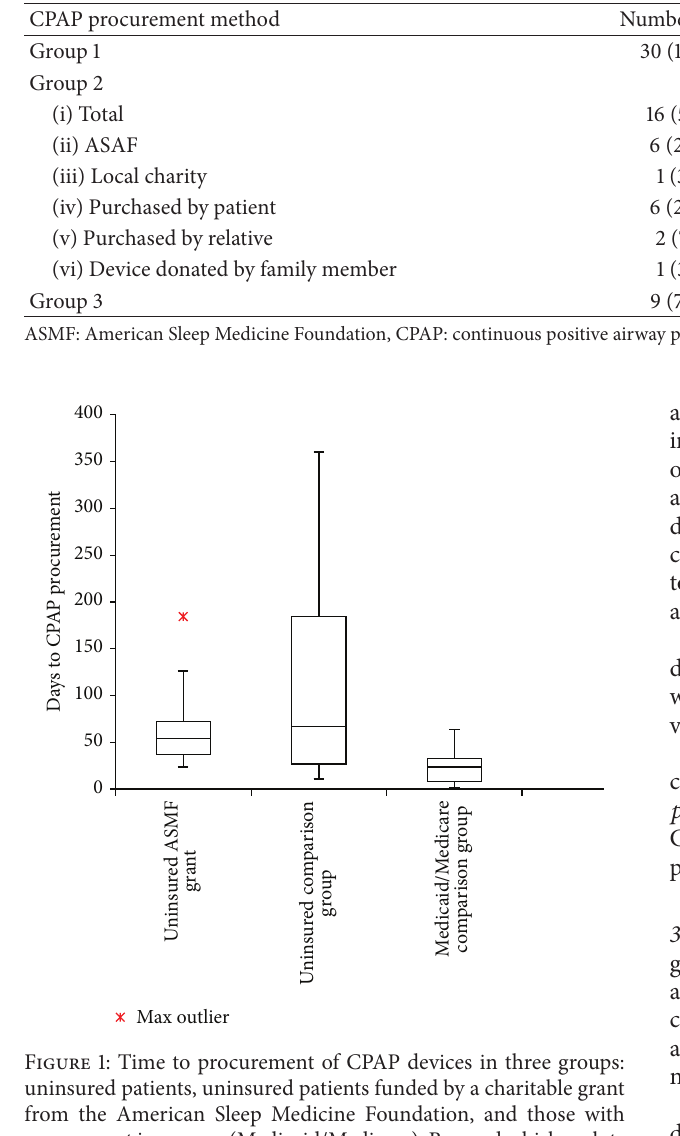
Table 2: Procurement data.